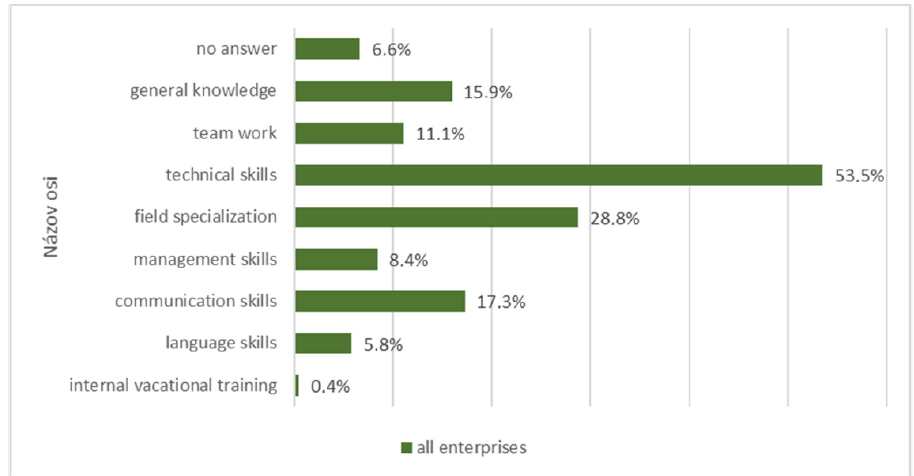
Figure 6. Reasons not to implement the Industry 4.0 concept in enterprises by size of enterprise.